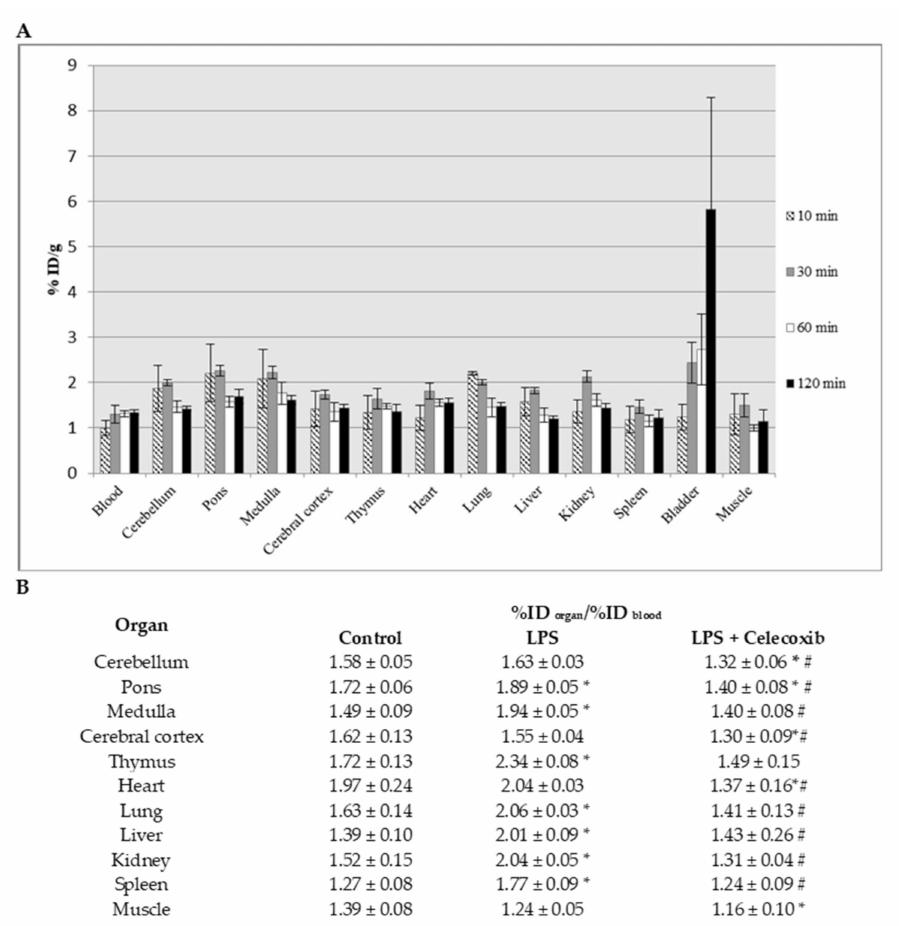
Figure 6. ( A ). Biodistribution data of [ 18 F]F-IV in %ID/g (dose administered per gram of tissue) at 10 ( n = 3), 30 ( n = 4), 60 ( n = 4), and 120 ( n = 3) min post-injection in intact rats. ( B ). Biodistribution data of [ 18 F]F-IV in %ID organ /%ID blood at 60 min post-injection in LPS, LPS + celecoxib, and intact rats. Data are provided as mean ± SEM ( n = 3) p < 0.05—* significant when compared with control group, # significant when compared with the LPS